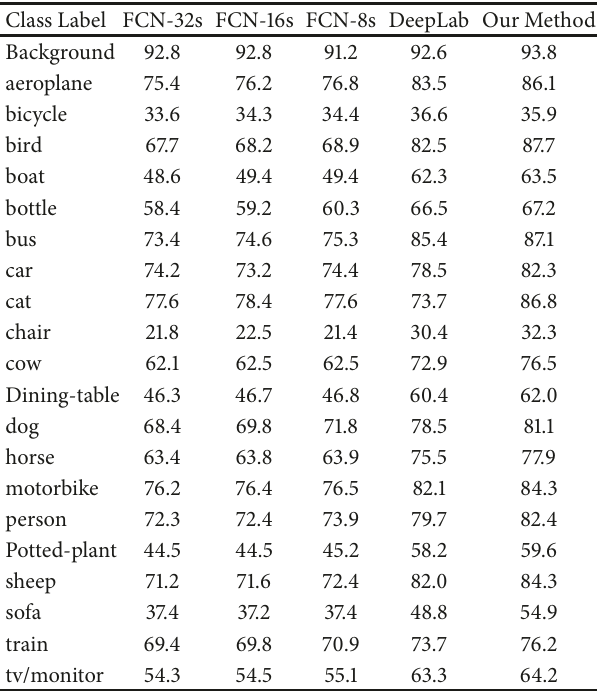
Table 1: Each class accuracy.